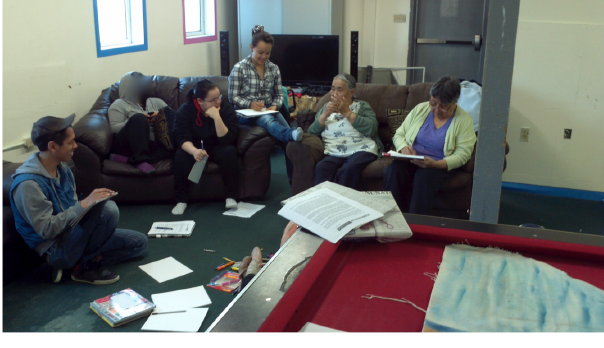
Fig. 3 . An action photo from our second workshop with Inuit youth and elders. Youth are sketching, while elders are sharing stories about experiences with the sea